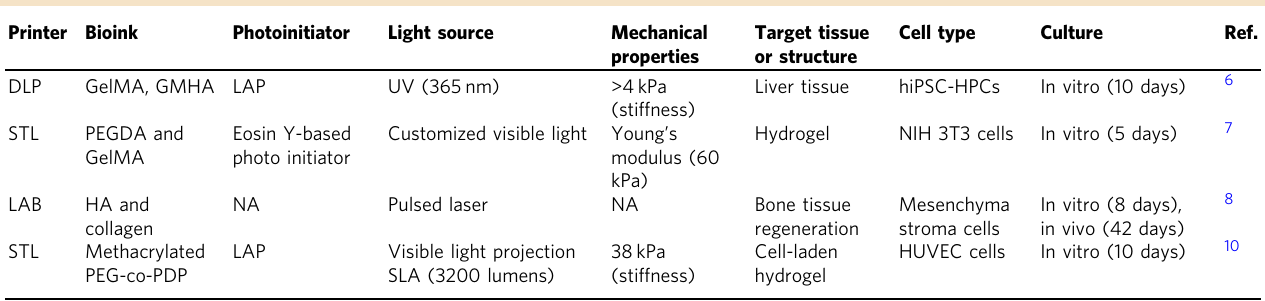
Table 1 Recent works on light-assisted